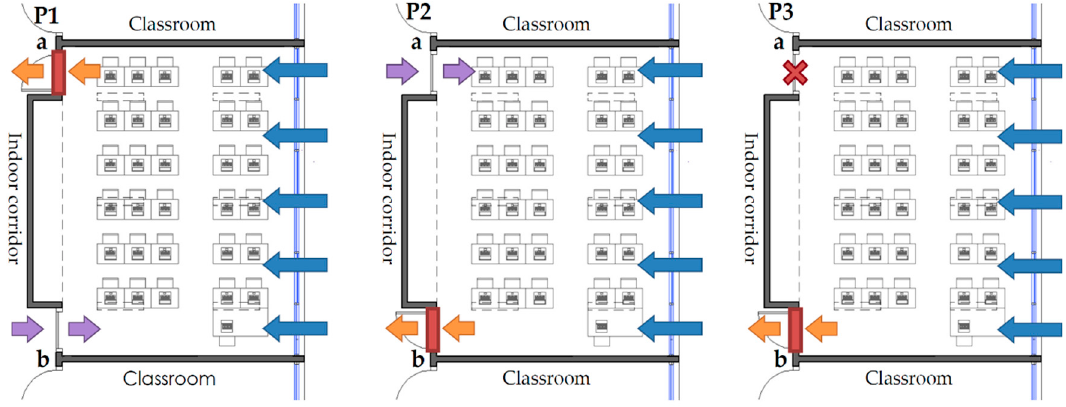
Figure 4. Protocols of Blower Door test.